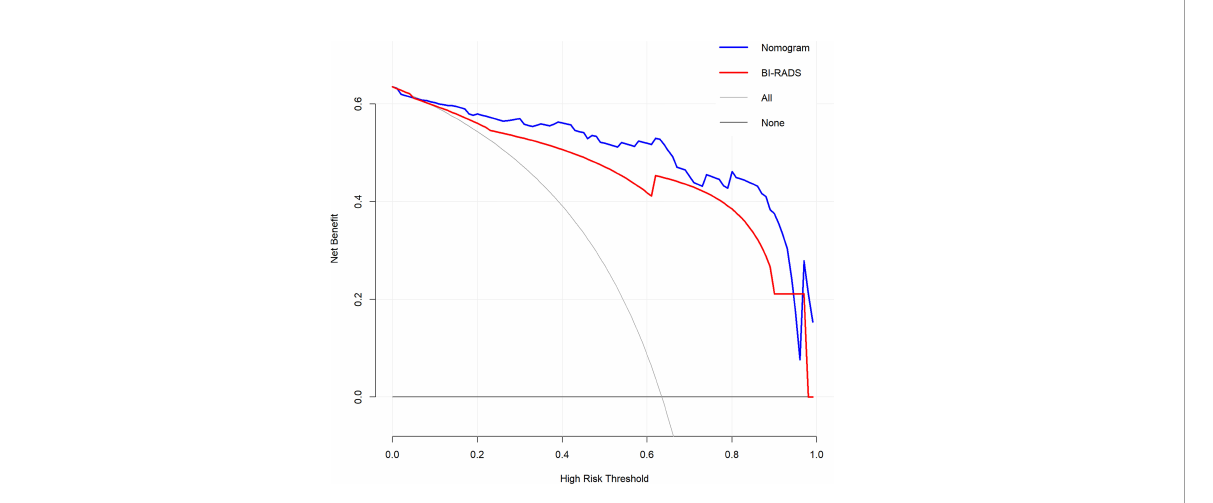
FIGURE 5 Decision curve analysis (DCA) for the radiomics nomogram and BI-RADS classi fi cation in the testing dataset. The y-axis represents the net bene fi